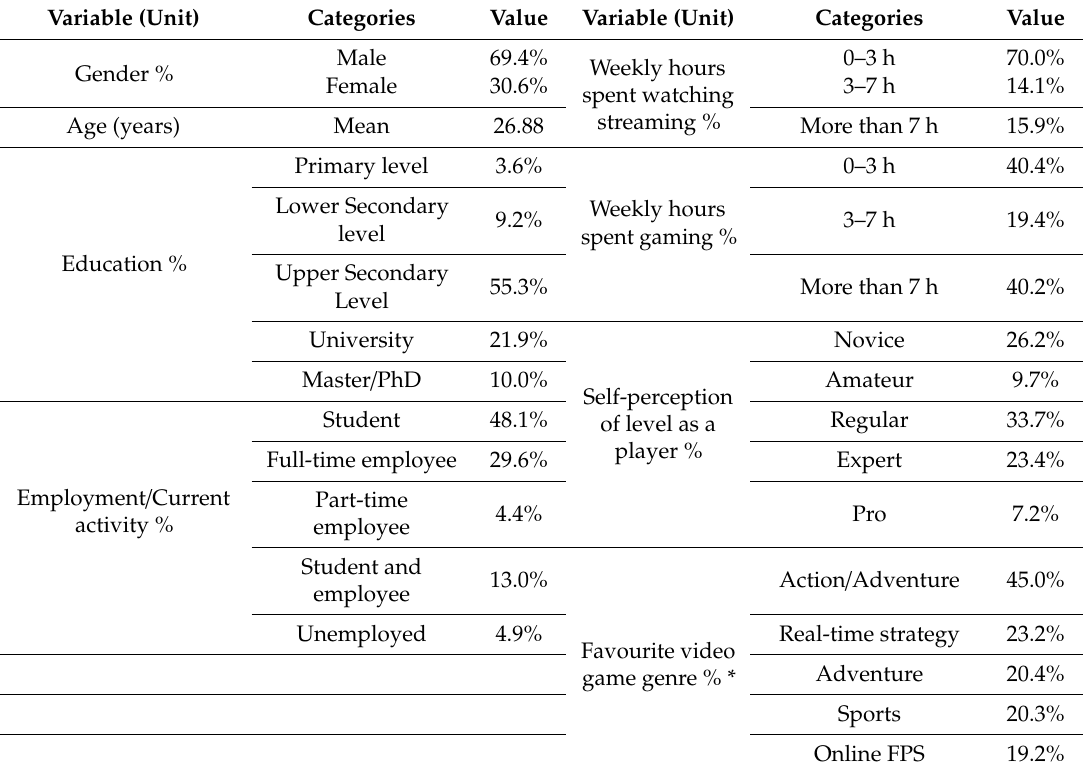
Table 1. Sociodemographic profile of the sample and profile of use of video game platforms. Variable